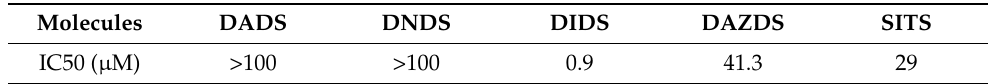
Figure 2. Effect of DIDS-derived small molecules on the ability to form D-loop structure. ( A ) D-loop structures in presence of increasing concentration of DIDS analogs (5, 25, 50, 145, and 100 µM) were separated and visualized on agarose gel. Last lane corresponds to the control condition without DIDS-derived molecule. ( B ) After quantification of signal intensity of shifted band corresponding to D-loop structure, the percent of D-loop is calculated in comparison to the condition in absence of drug and presented in relation to the increasing concentration (from 1 to 100 µM) of each small molecule. Three independent experiments were performed and each error bar represents s.d. statistical analysis. Table 1. IC50 determination from D-loop data of the Figure 2.